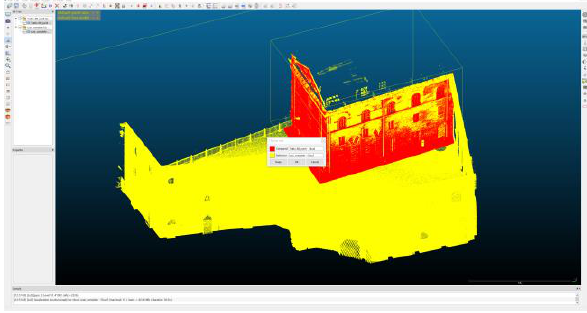
Figure 8. Cloud comparison using cloud-cloud distance method., the laser scanner cloud used as a reference in yellow and the photogrammetric cloud in red